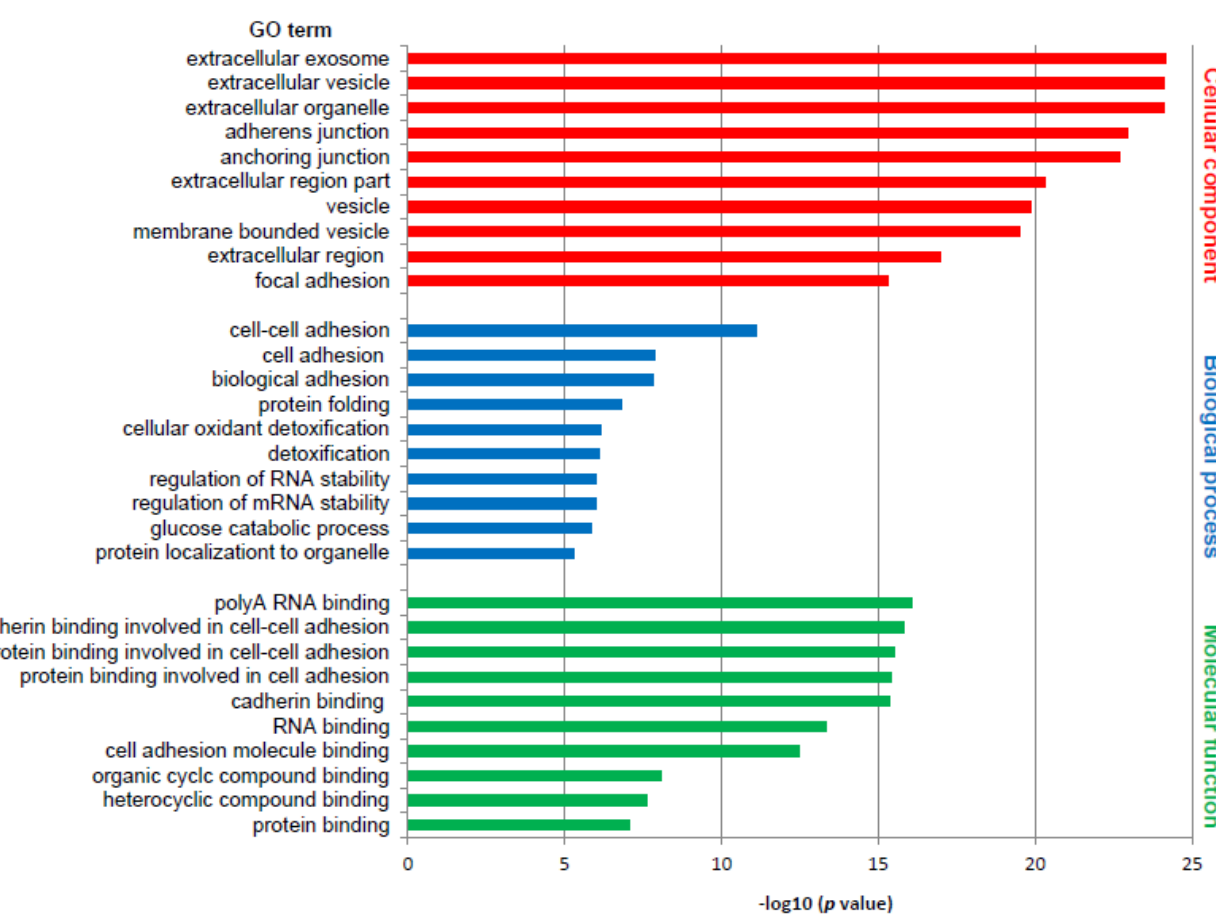
Figure 1. GO enrichment analysis of differentially expressed proteins in RTI-positive compared to -negative CS I seminomas. The 10 most significantly ( p < 0.05) enriched GO terms in molecular function (green), biological process (blue), and cellular component (red) are presented. All adjusted p values of the GO terms were − log10 transformed.